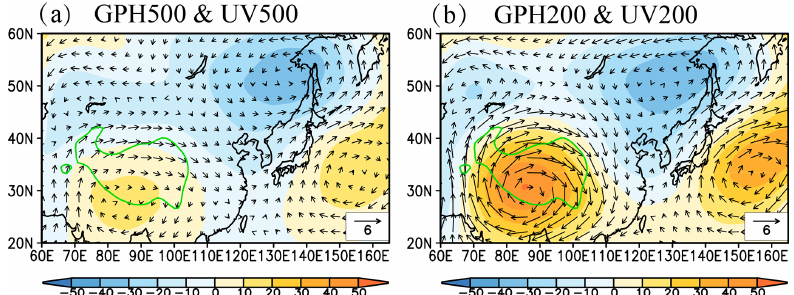
Figure 9. Spatial distribution of the MAM composite difference between the strongest and weakest TPSH years (strongest–weakest) for the model in geopotential height (GPH, gpm) and wind vectors (ms − 1 ) at the (a) 500hPa level and (b) 200hPa level. The green-contour area indicates the plateau above